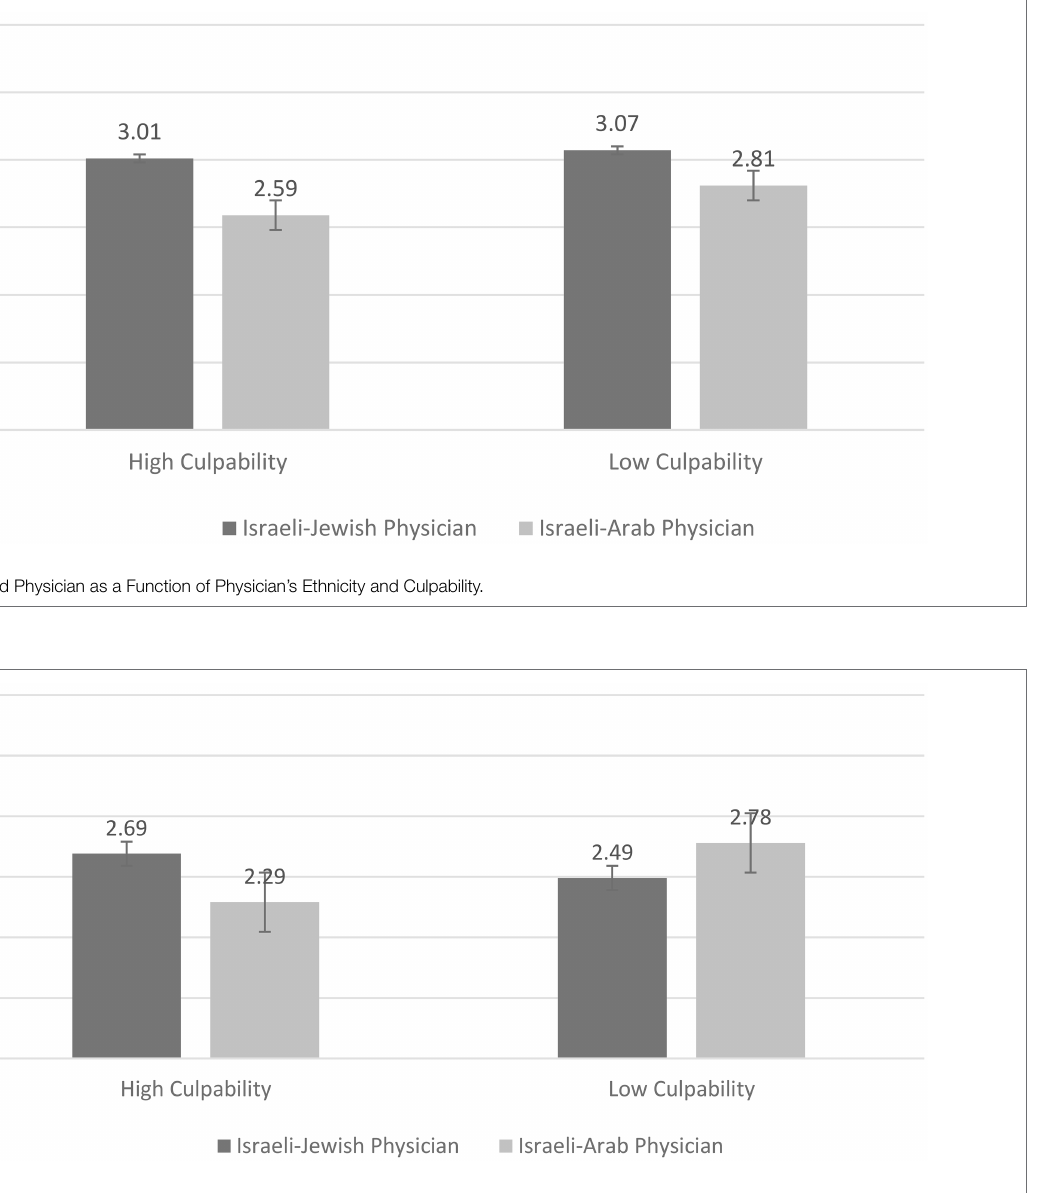
FIGURE 2 | Trust in Physician as a Function of Physician’s Ethnicity and